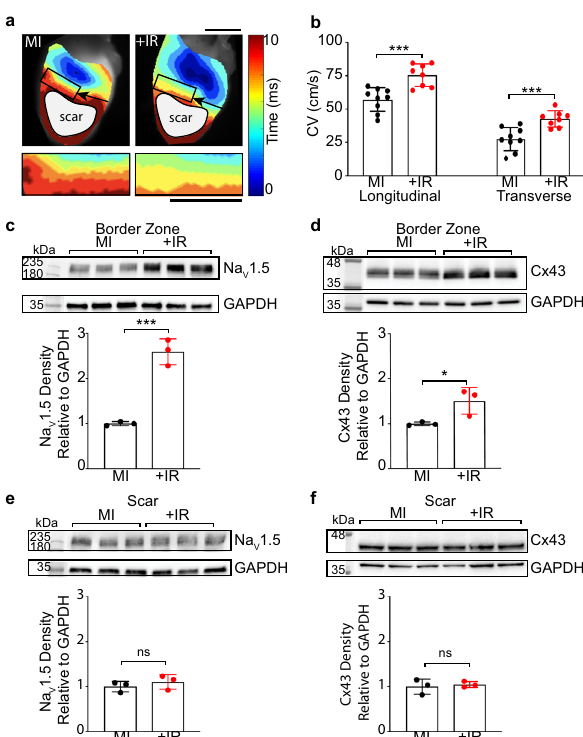
Fig. 4 Radiation speci fi cally reprograms the border zone myocardium in a murine model of myocardial infarction. a Top: representative ventricular activation maps from control myocardial infarction (MI, left) and irradiated MI (MI + IR, right) mice at 8 weeks post-MI and 6 weeks post-IR. Black arrows point to location of left anterior descending (LAD) artery ligation. Black box denotes approximate 2 mm border zone at the scar/myocardium interface. Regions of scar that were epicardially stimulated but did not capture are denoted by gray circles. Magni fi ed isochrones in the border zone region used to calculate transverse conduction velocities. Scale bars = 5 mm. b Left ventricular conduction velocities in MI (black) versus MI + IR (red) hearts (MI n = 9 biologically independent animals; MI + IR n = 8 biologically independent animals; longitudinal *** P = 0.0006; transverse *** P = 0.0009;). c , d Western blot (top) and quanti fi ed density (bottom) of Na V 1.5 (*** P = 0.0007) and Cx43 (* P = 0.041) protein in MI and MI + IR border zone myocardium superior to the LAD ligation ( n = 3 biologically independent samples per condition). e , f Western blot (top) and quanti fi ed density (bottom) of Na V 1.5 ( P = 0.42) and Cx43 ( P = 0.68) protein in MI control and MI + IR apical scars ( n = 3 biologically independent samples per condition). All P values determined by two-way unpaired t test. All bar graphs are represented as mean ± SD. Source data are provided as a Source data fi